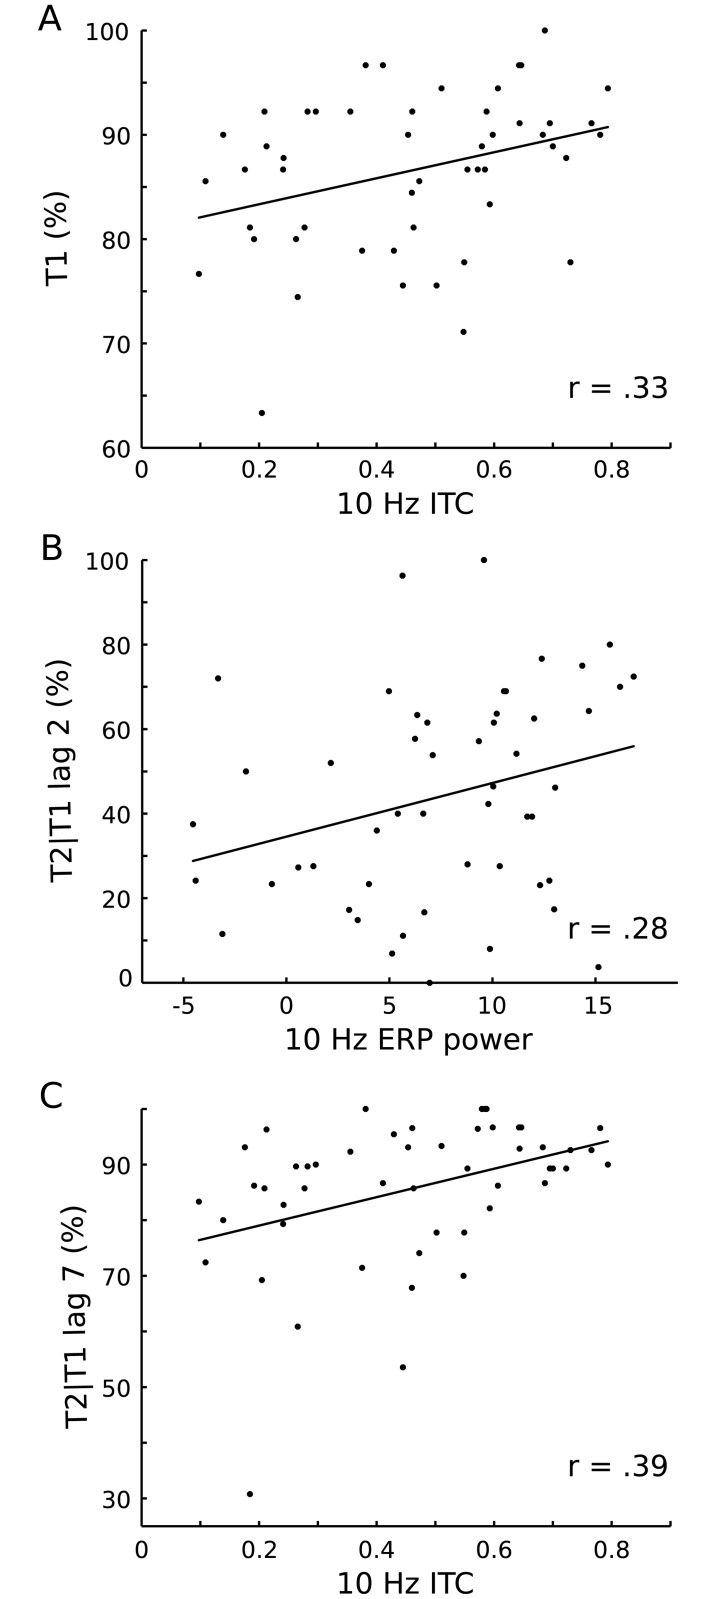
Significant correlations between 10 Hz ITC and task performance.(A) T1 identification rate as a function of 10 Hz ITC. The black line corresponds to the linear regression line. (B) Identification rate for T2|T1 lag 2 as a function of 10 Hz ERP power. The black line corresponds to the linear regression line.